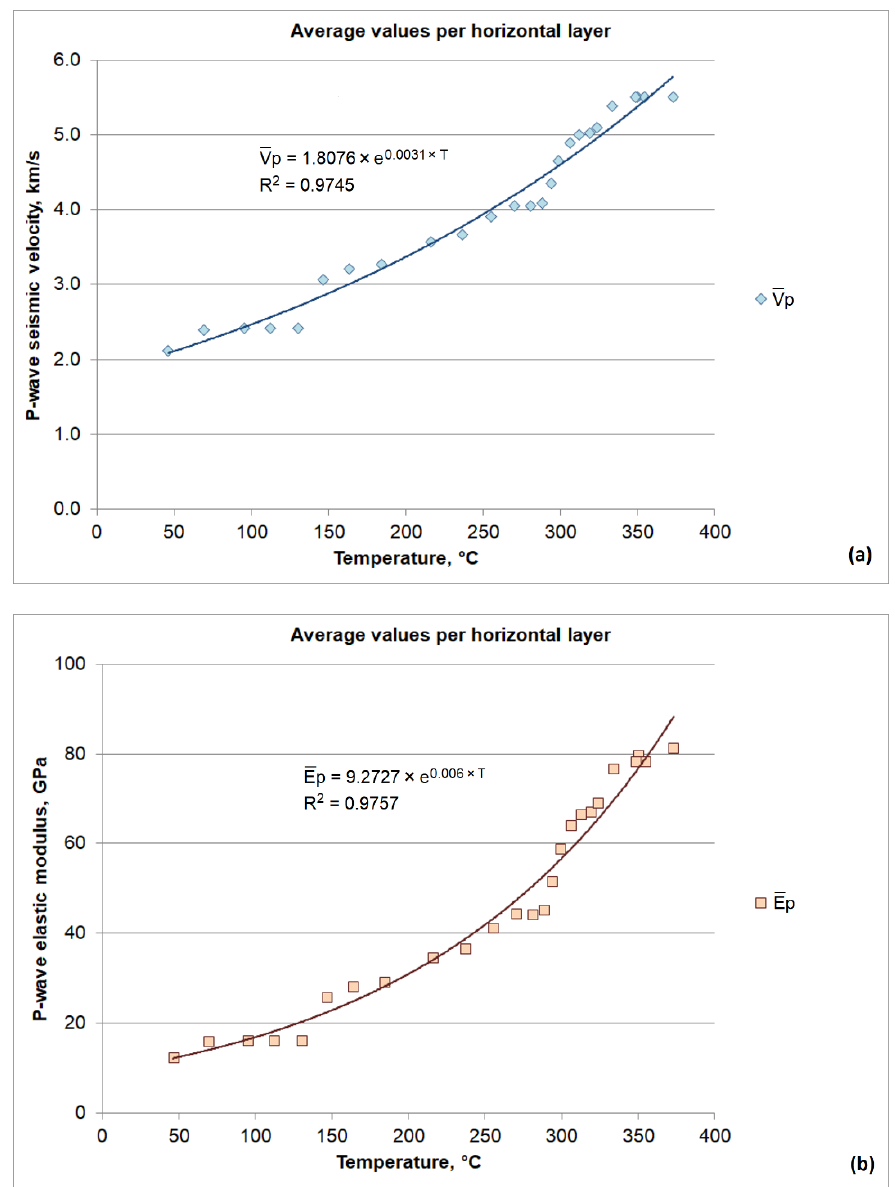
Figure 5. Correlation of 1-D p -wave seismic velocities V P ( a ) and 1-D elastic modulus E P ( b ) averaged in the same elevation above sea level, as derived from the active seismic survey, with averaged natural state temperatures at the same horizontal elevation in Los Humeros.